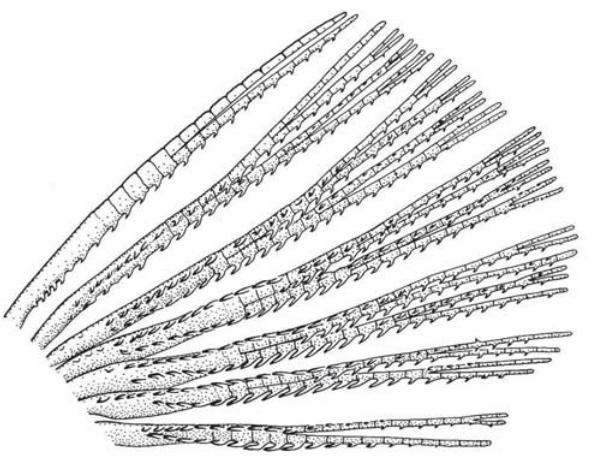
Fig. 74. Mimagoniates rheocharis , adult male, USNM 279879, paratype, 45.4 mm SL; pelvic fin of adult male, ventral view, left side, anterior at left. Modified from Menezes & Weitzman (1990).